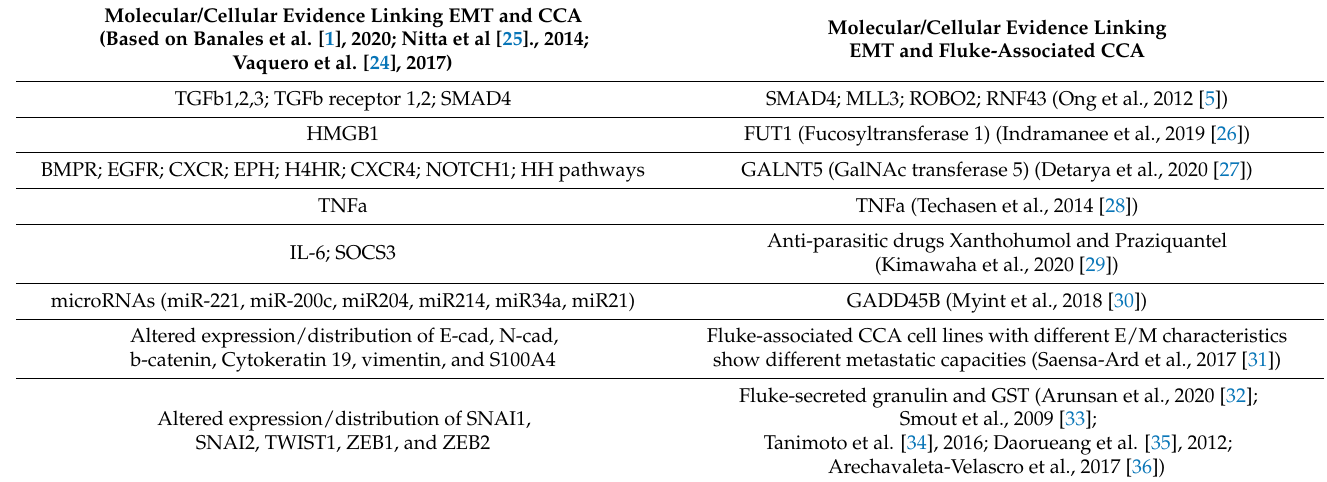
Table 1. Molecular and cellular evidence linking EMT with CCA. Left column: EMT and CCA; Right column: EMT and fluke-associated